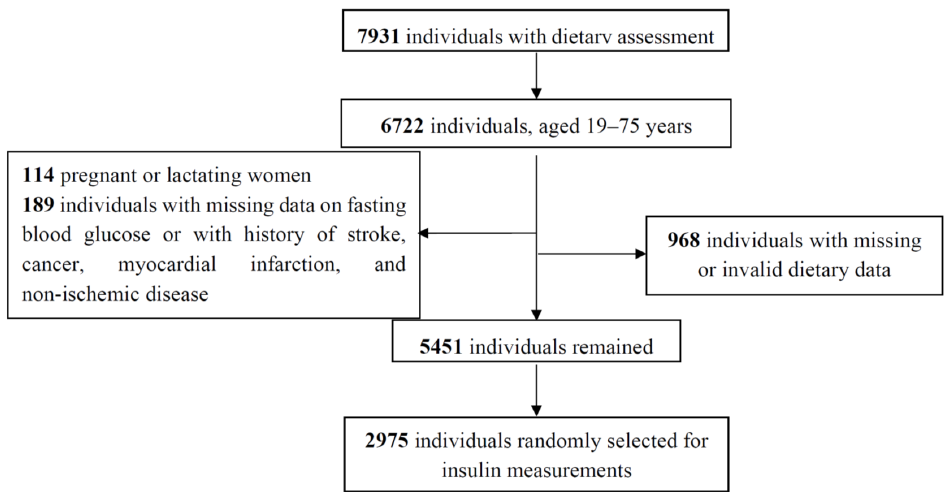
Figure 1. Selection of study participants.